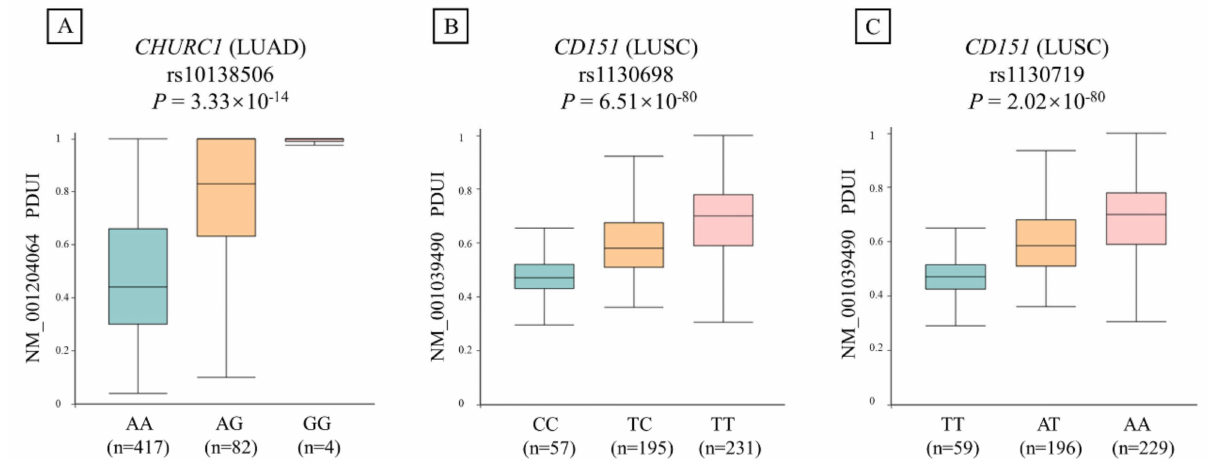
Figure 2. The relationship between three candidate apaQTL-SNPs and PDUI values of their target genes in NSCLC. ( A ) The variant G allele of apaQTL-SNP rs10138506 was significantly associated with higher PDUI values in LUAD. ( B ) The variant C allele of apaQTL-SNP rs1130698 was significantly associated with lower PDUI values in LUSC. ( C ) The variant T allele of apaQTL-SNP rs1130719 was significantly associated with lower PDUI values in LUSC. apaQTL, alternative polyadenylation quantitative trait loci; SNP, single nucleotide polymorphisms; PDUI, percentage of distal poly(A) site usage index; NSCLC, non-small-cell lung cancer; LUAD, lung adenocarcinoma; LUSC, lung squamous cell carcinoma.